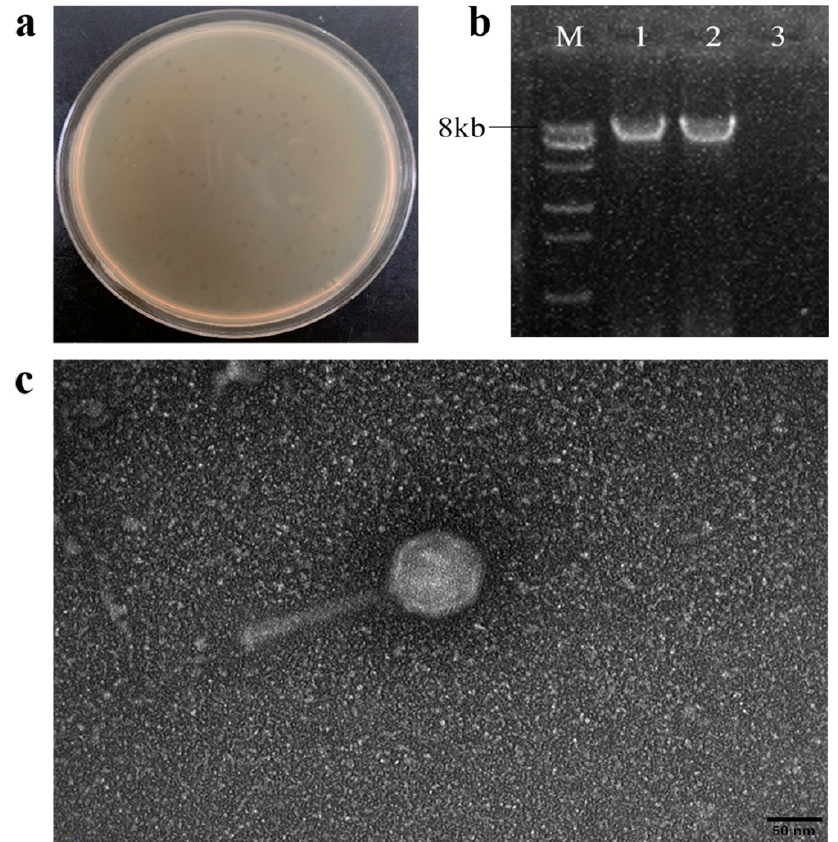
Figure 1. The morphology characteristics of phage PHB09. ( a ) Plaque morphology of phage PHB09. ( b ) Agarose gel electrophoresis of genomic segments. M: DNA marker, 1: PHB09 genome, 2: PHB09 genome digested with RNase, and 3: PHB09 genome digested with DNase. ( c ) Virion morphology observation of phage PHB09 under TEM.